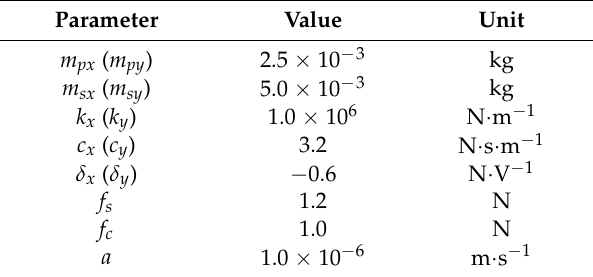
Table 1. Parameters of the parallel 2-DOF linear